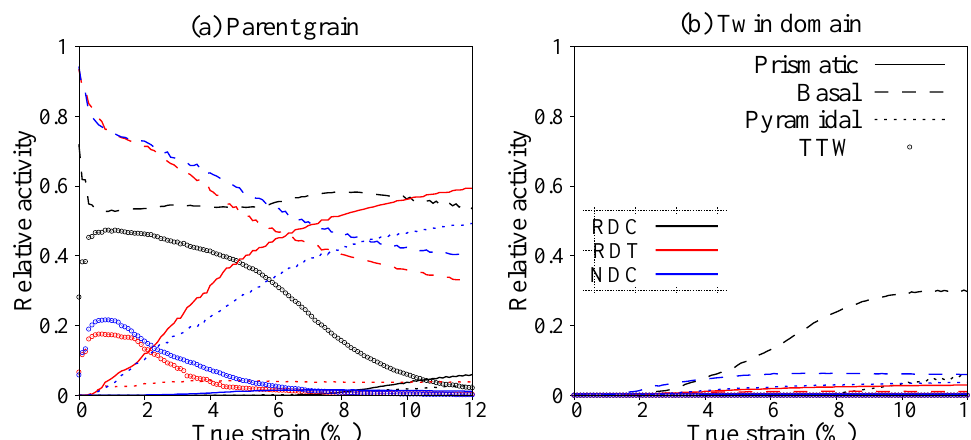
Figure 3. Relative contribution of basal, prismatic, and pyramidal slip modes, and tensile twinning in the ( a ) parent grain and ( b ) newly formed twinned grains for Mg-0.05%Y alloy. Here, the color scheme represents the loading condition, and curve symbols denote different deformation modes. For example, the black, red, and blue curves correspond to RDC, RDT, and NDC, respectively. The solid, dashed, dotted, and circles correspond to prismatic, basal, pyramidal, and tensile twins.